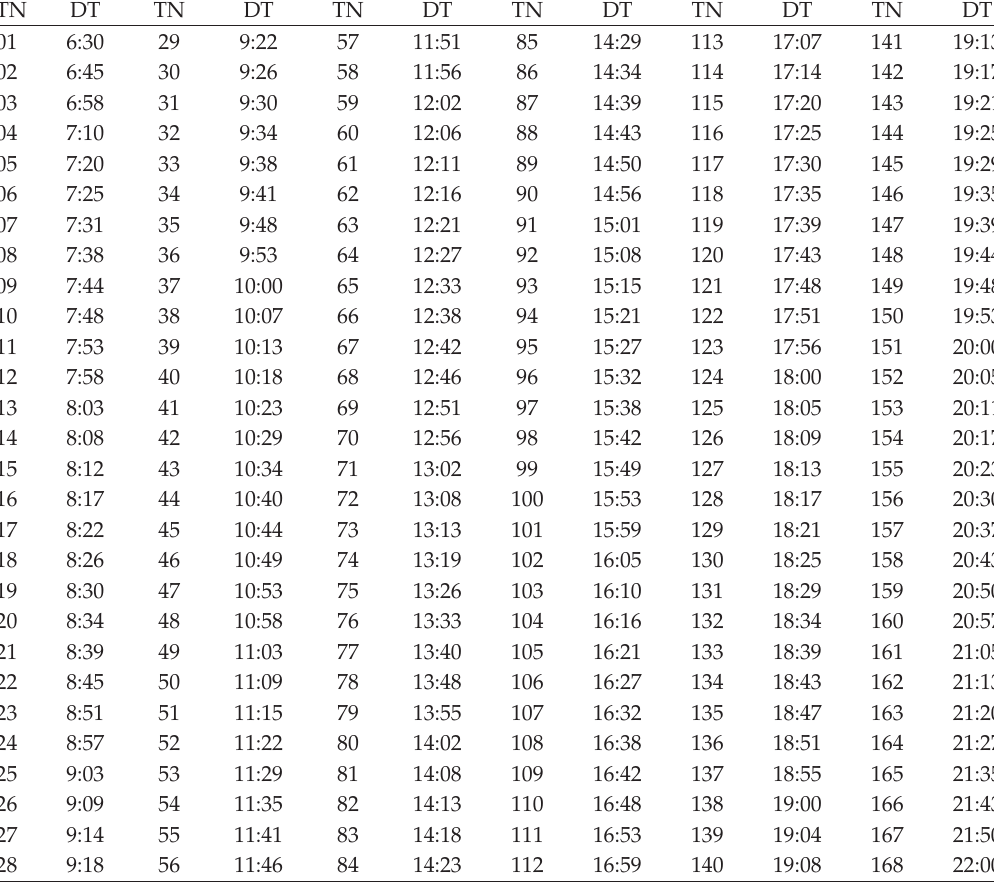
Table 1: Departure time of